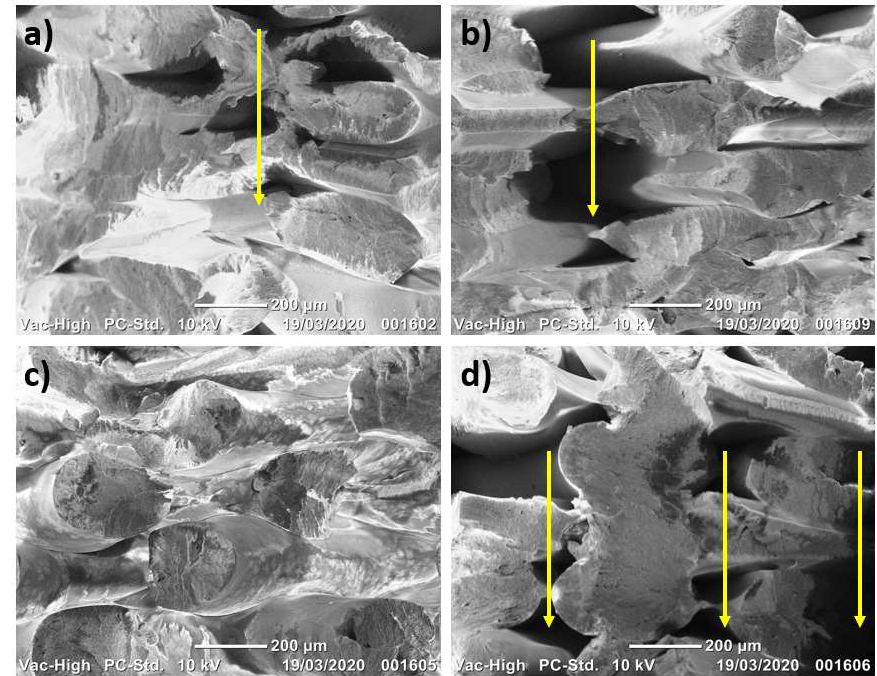
Figure 15. SEM micrographs for ABS material: ( a ) Control ABS; ( b ) Annealed at 105 °C; ( c ) Annealed at 115 °C; ( d ) Annealed at 125 °C. J. Manuf. Mater. Process. 2020 , 4 , x FOR PEER REVIEW